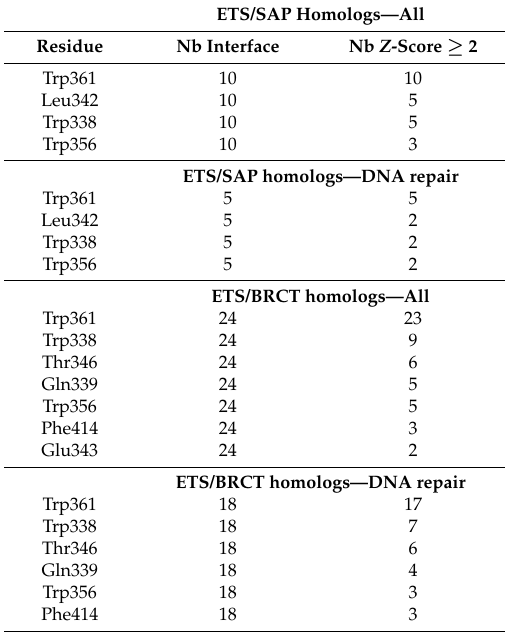
Table 2. Residues of the ETS domain of Ets-1 found at the interface that have a Residue Centrality Analysis Z -score ≥ 2 at least twice in the set of structures. The table shows the number of times the residue is found (written “Nb”) at the interface and the number of times it has a Z -score ≥ 2. It presents the results for four sets of structures: all ETS/SAP homologs (10 structures), ETS/SAP homologs involved in DNA repair (5 structures), all ETS/BRCT homologs (24 structures) and ETS/BRCT homologs involved in DNA repair (18